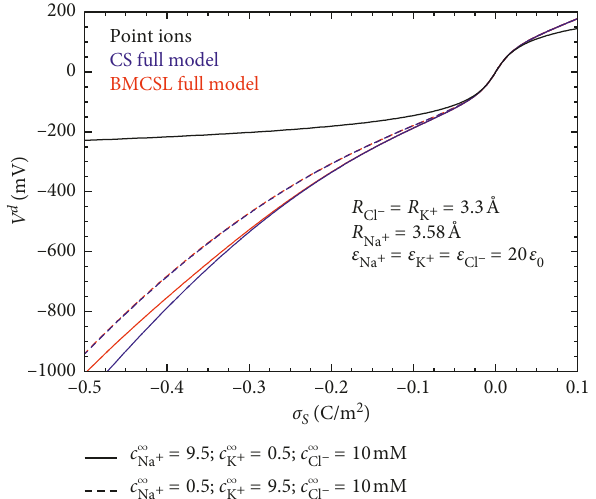
Figure 9: Dependence of the electric potential drop across the diffuse electric double layer on the surface charge density calculated using the CS and BMCSL full models and mixed aqueous NaCl and KCl solutions with the indicated